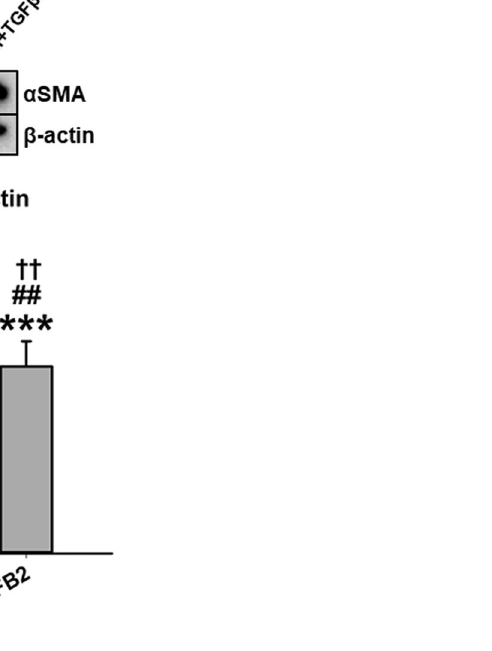
Figure 3. GIMs increase hTM cell contractility by overexpressing α-smooth muscle actin in the presence of exogenous TGFβ2. Primary hTM cells were cultured in the presence or absence of 100 nM dexamethasone for 4 weeks in complete growth media. Cells were subsequently removed using 20 mM ammonium hydroxide solution to obtain GIMs and vehicle control matrices (VehMs). Same strain, fresh primary hTM cells were then seeded on these matrices with or without exogenous 5 ng/mL TGFβ2 in 1% fetal bovine serum growth media for 7 days. Protein was extracted for Western blot analysis. β-Actin was used as an internal control for normalization. Representative cropped blot (top) and densitometric analysis (bottom) of α-Smooth muscle actin (αSMA). Columns and error bars ; means and standard error of mean (SEM). One-way ANOVA with the Tukey pairwise comparisons post hoc test was used for statistical analysis. (n = 4 biological replicates. *p < 0.05, ***p < 0.001 for the group of interest versus control, VehM. ##p < 0.01 for the group of interest versus GIM. †† p < 0.01 for comparison between VehM + TGFβ2 and GIM + TGFβ2). hTM, human trabecular meshwork. Black horizontal demarcating line between the blot image signifies two images were taken at different parts of the same membrane blot. Full length blots can be found in Supplementary Figs. S5F and S6F. Densitometric analyses was done using ImageJ 1.8.0_112 software (https ://image j.nih.gov/ij/,